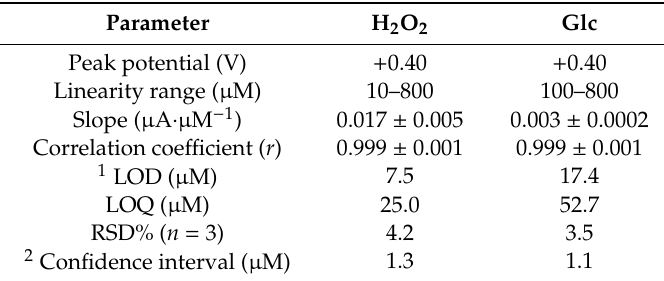
Table 1. The analytical parameters obtained for the calibration of H 2 O 2 (at GCE / MWCNTs-RuO 2